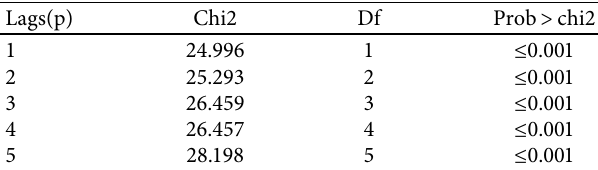
Table 3: The ARCH LM test of residual sequence.